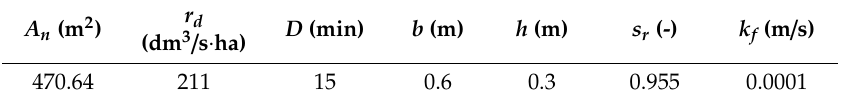
Table 10. Data used for calculating the length of the infiltration boxes.